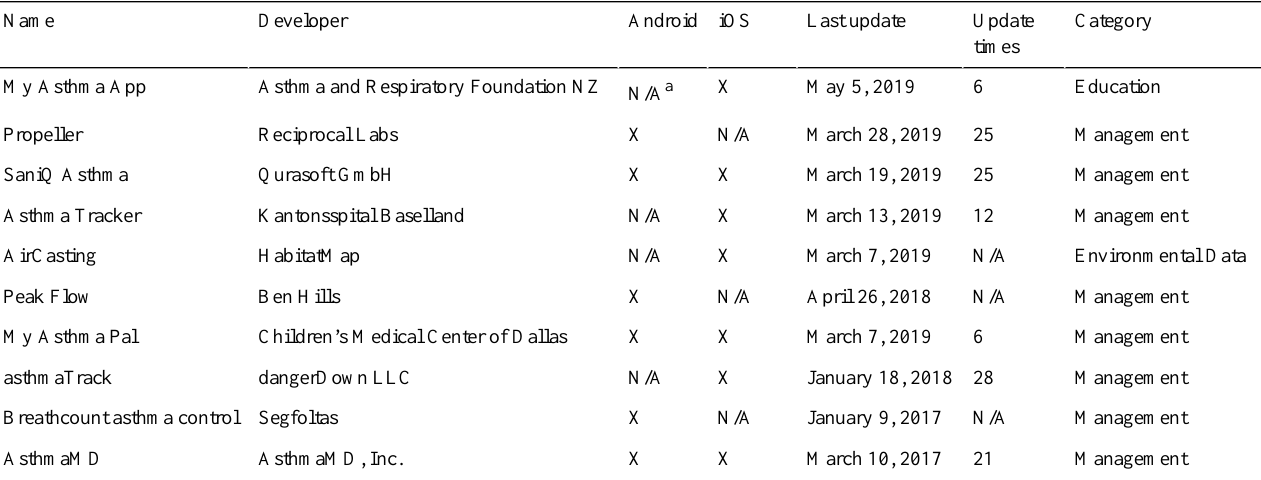
Table 1. List of asthma mobile apps included in